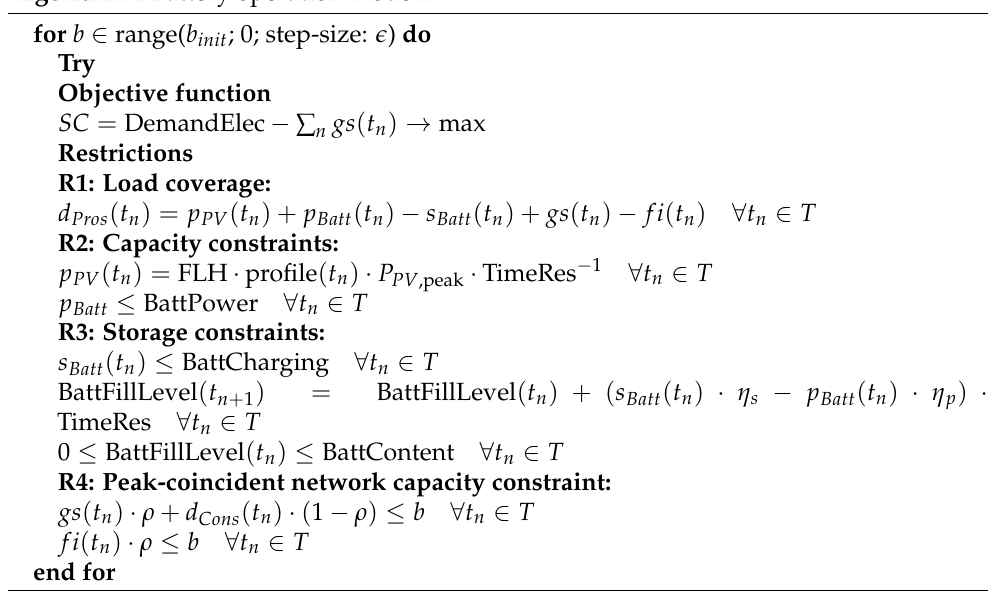
Algorithm 1 Battery operation mode